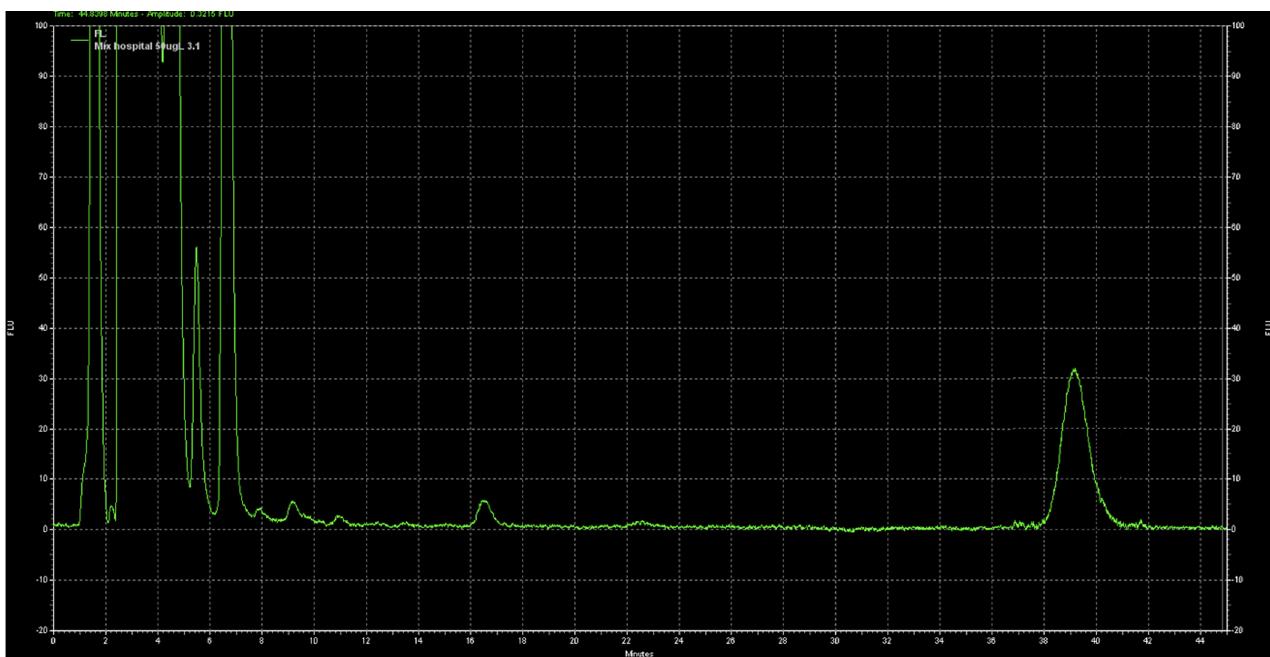
Figure A2. HPLC–FLD chromatogram of a hospital wastewater spiked with 50 ng/mL BICA, using the method’s final conditions: 0.2 mL/min as flow rate; 65:35 UPW:ACN, both acidified with 0.1% formic acid, as mobile phase; and 272/318 nm as excitation/emission wavelengths.